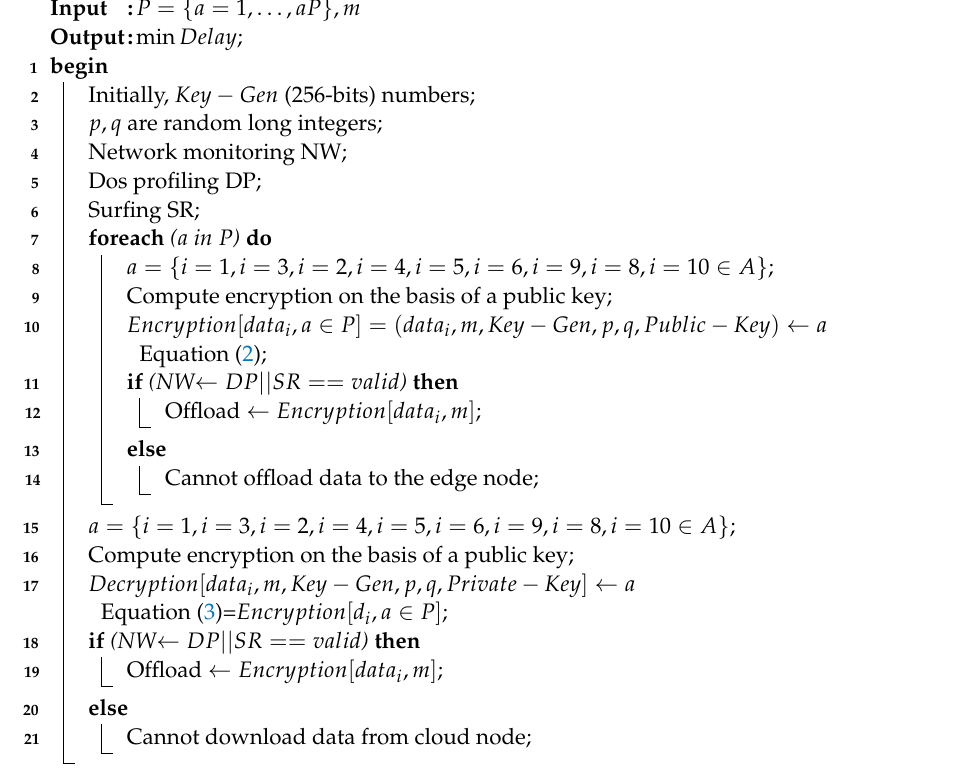
Algorithm 3: Lightweight two-way homomorphic security